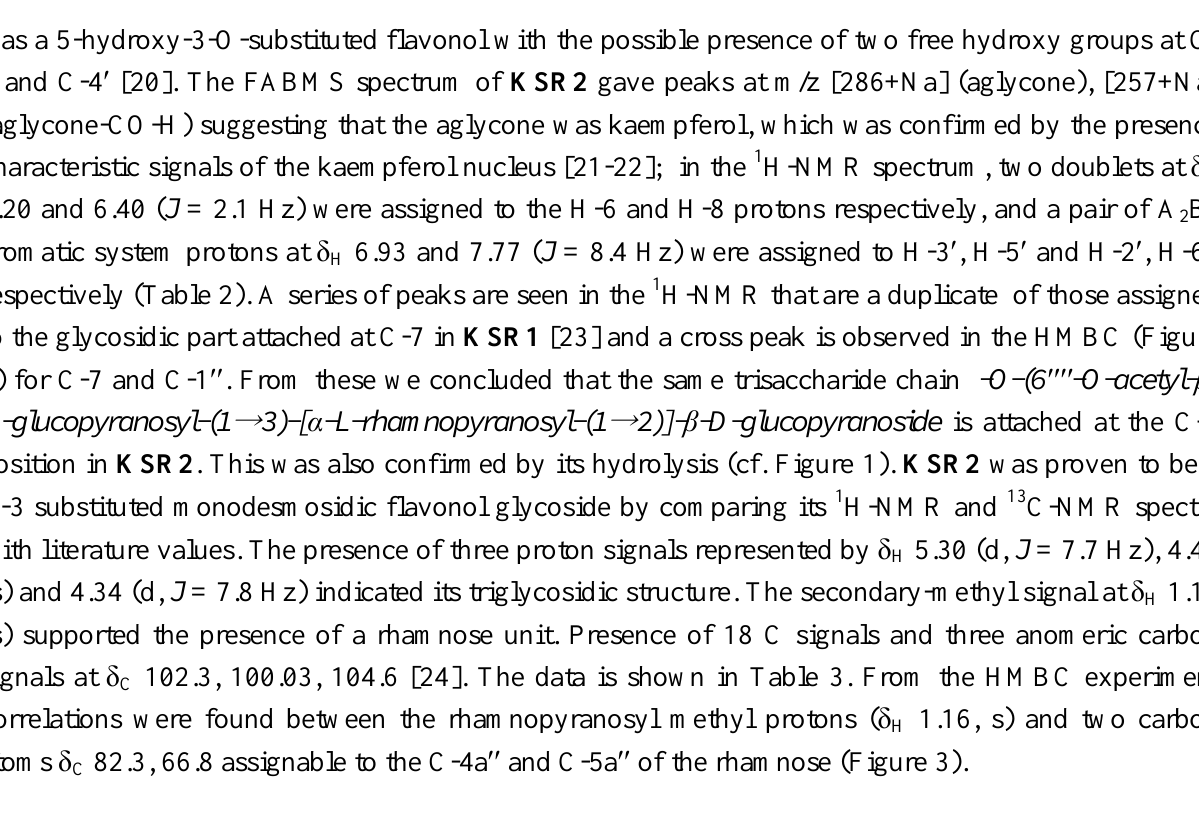
Figure 3 . Significant HMBC Correlations for KSR2 . Arrows point from H to